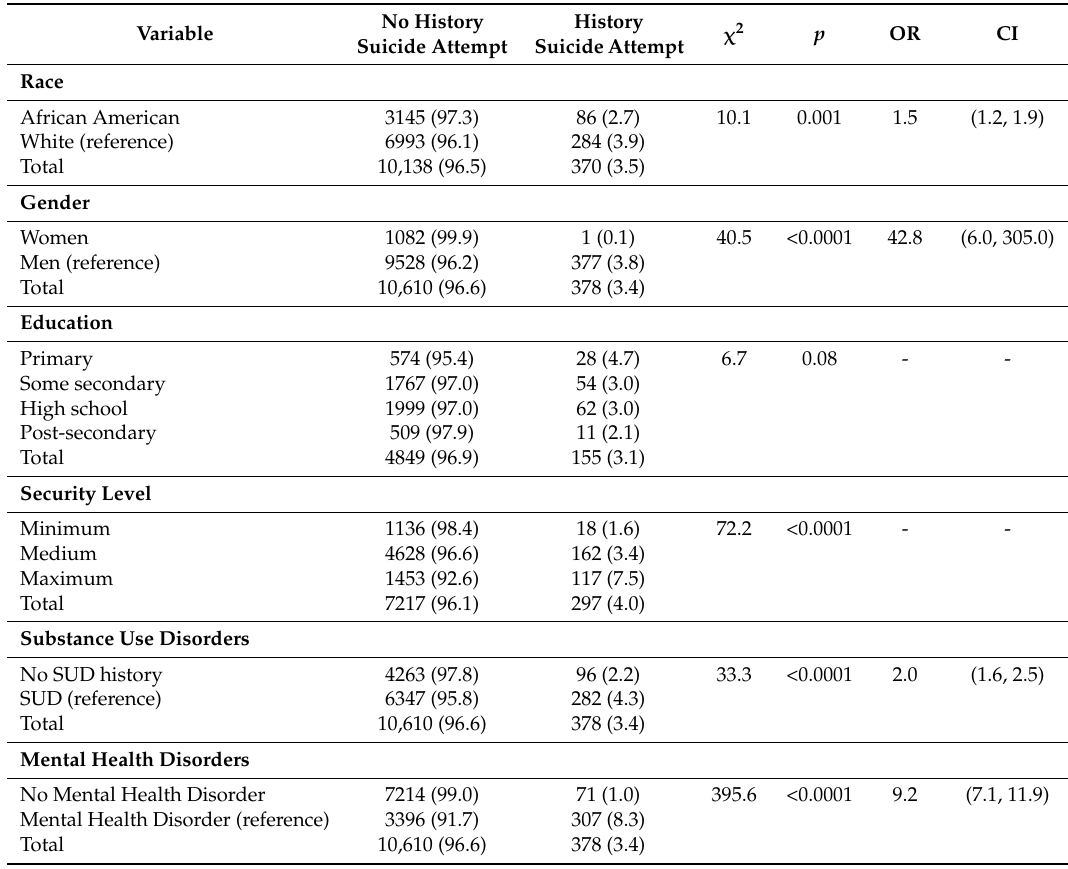
Table 4. Group differences for suicide